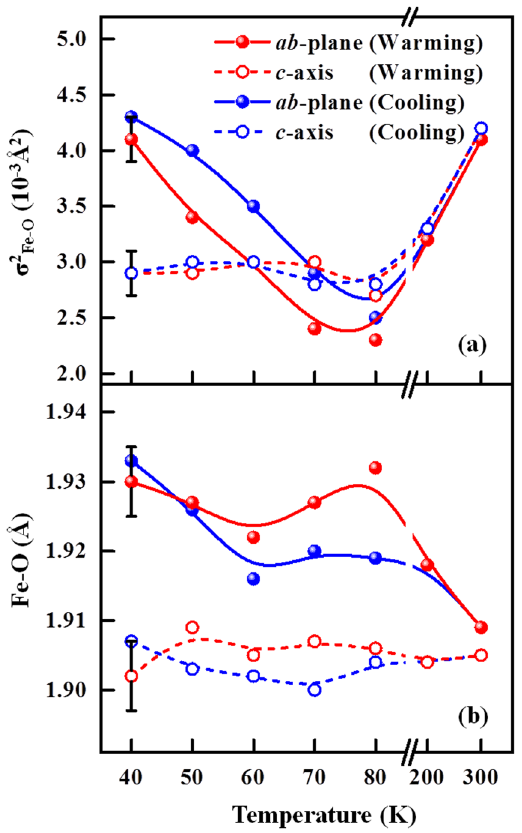
Figure 6. Variation of ( a ) DW factors and ( b ) NN Fe-O bond lengths with temperature, obtained by fitting temperature-dependent Fe K -edge EXAFS for R from 1.15 to 1.96 Å with angle of incidence θ = 0°, and R from 1.04 to 1.77 Å with angle of incidence θ =